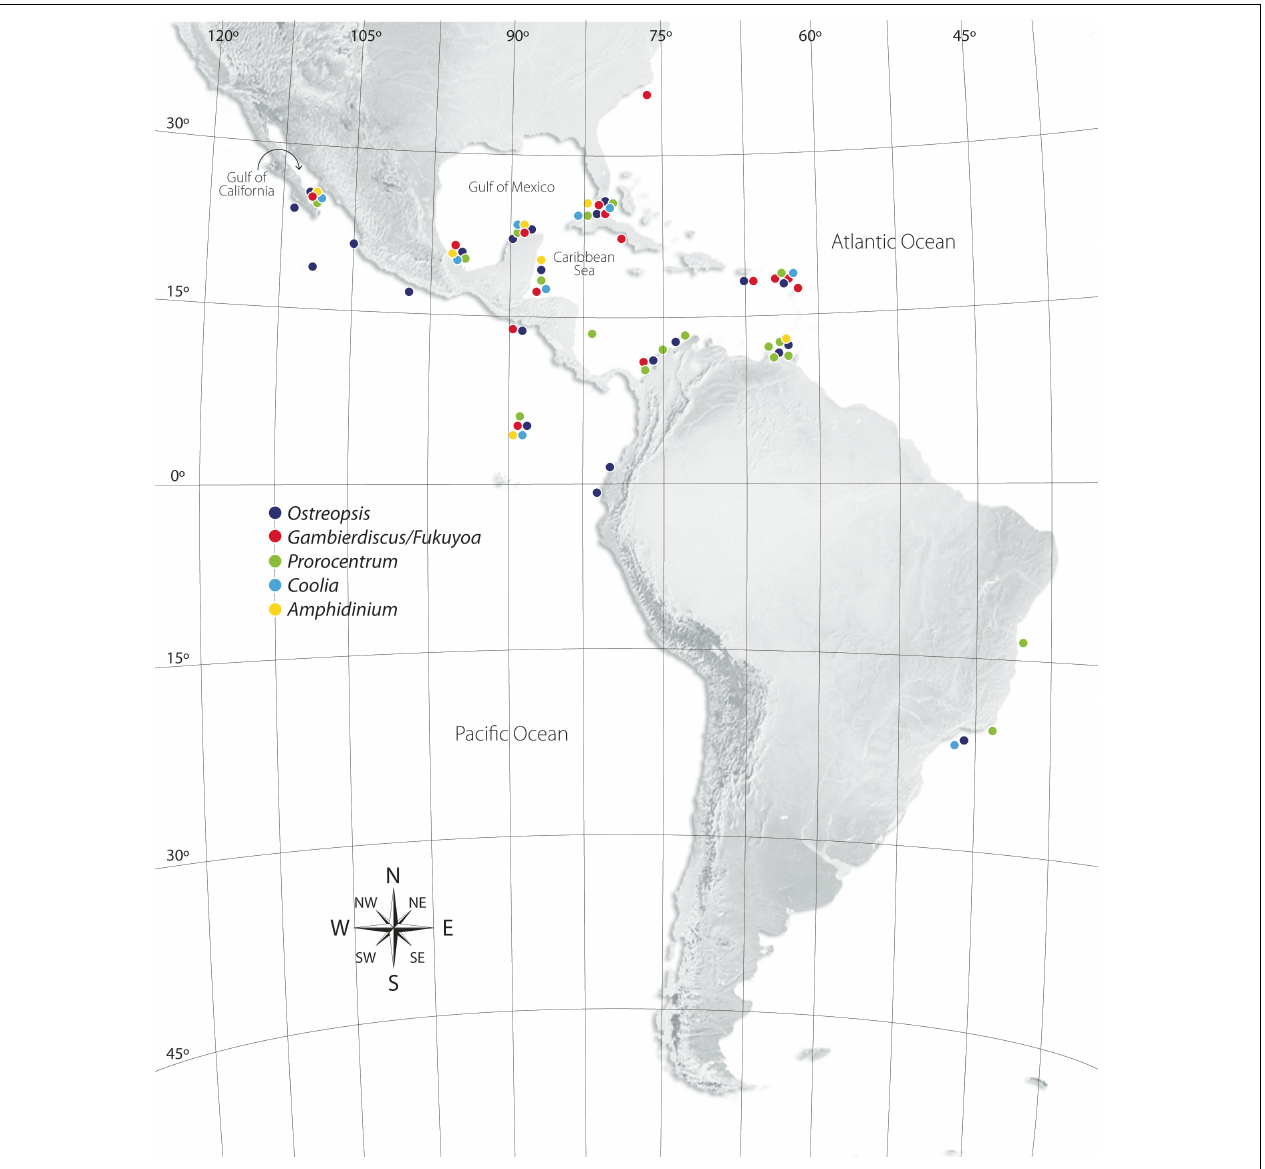
FIGURE 1 | Known biogeographical distribution of dinoflagellate genera with toxigenic benthic members from tropical and subtropical waters of Latin America, as well as the Caribbean Sea and adjacent coasts of the Americas. Genera including toxigenic benthic species were obtained from the IOC-Harmful Microalgal Species list (Moestrup et al., 2009), but the map may include taxa not yet confirmed as toxigenic at the specified locations.